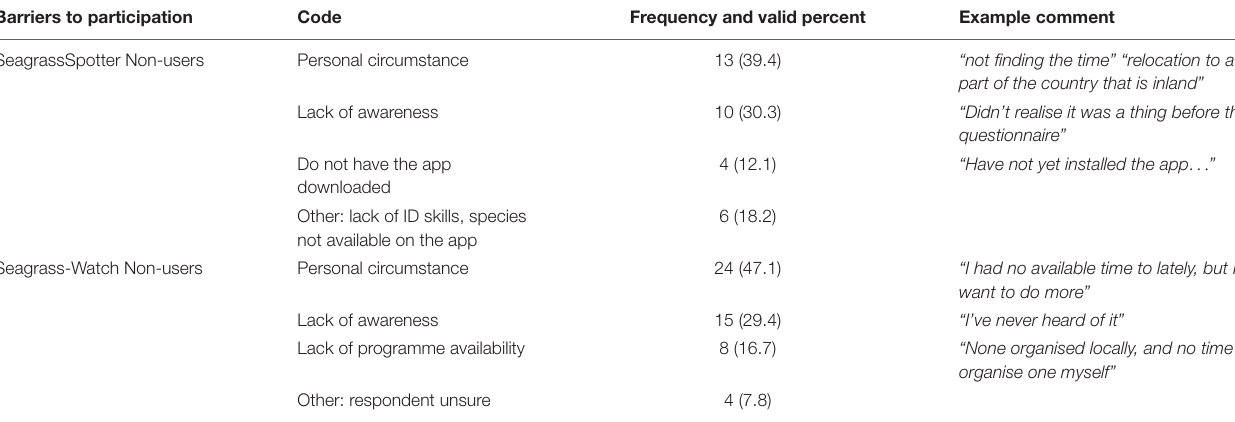
TABLE 7 | Perceived barriers to participation in seagrass citizen science projects from non-users. Barriers to